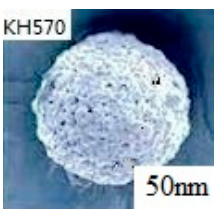
Figure 17. Scanning electron microscope of coupling agent modified nano-SiO 2 Emulsified Rubber Particles.